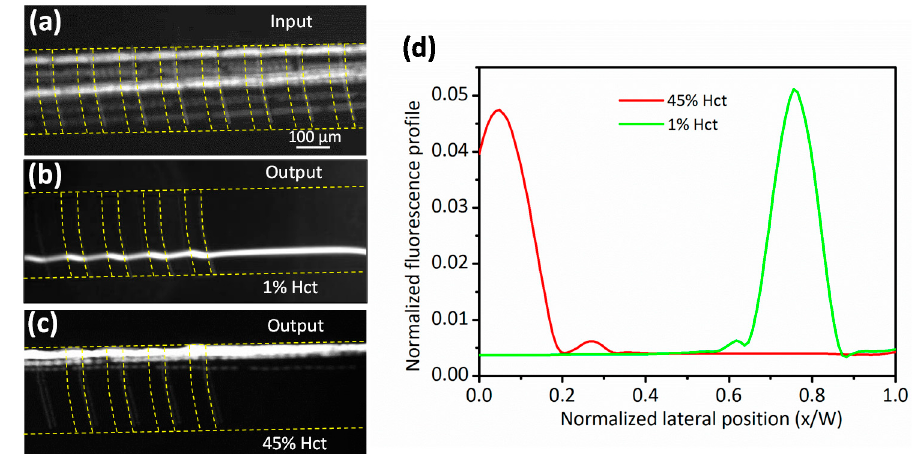
Figure 2. Experimentally focused patterns of 13-µm diameter particles at various sample hematocrits. The applied flow rate was 10 µL·min − 1 . ( a ) Beads were introduced evenly at the inlet. The microscopy images show the trajectories of particles along the hydrophoretic channel at 1% Hct ( b ) and 45% Hct ( c ); ( d ) measured fluorescence profiles of particle trajectories.